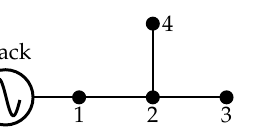
Figure 2. Distribution test feeder composed of four